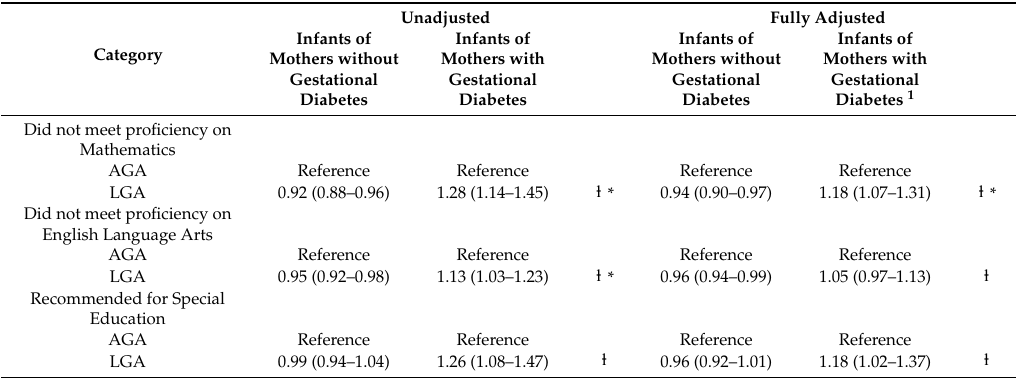
Table 3. Relative Risks and Effect Modification for those born LGA compared to those born AGA by Maternal Gestational Diabetes Status ( n = 108,348). Unadjusted